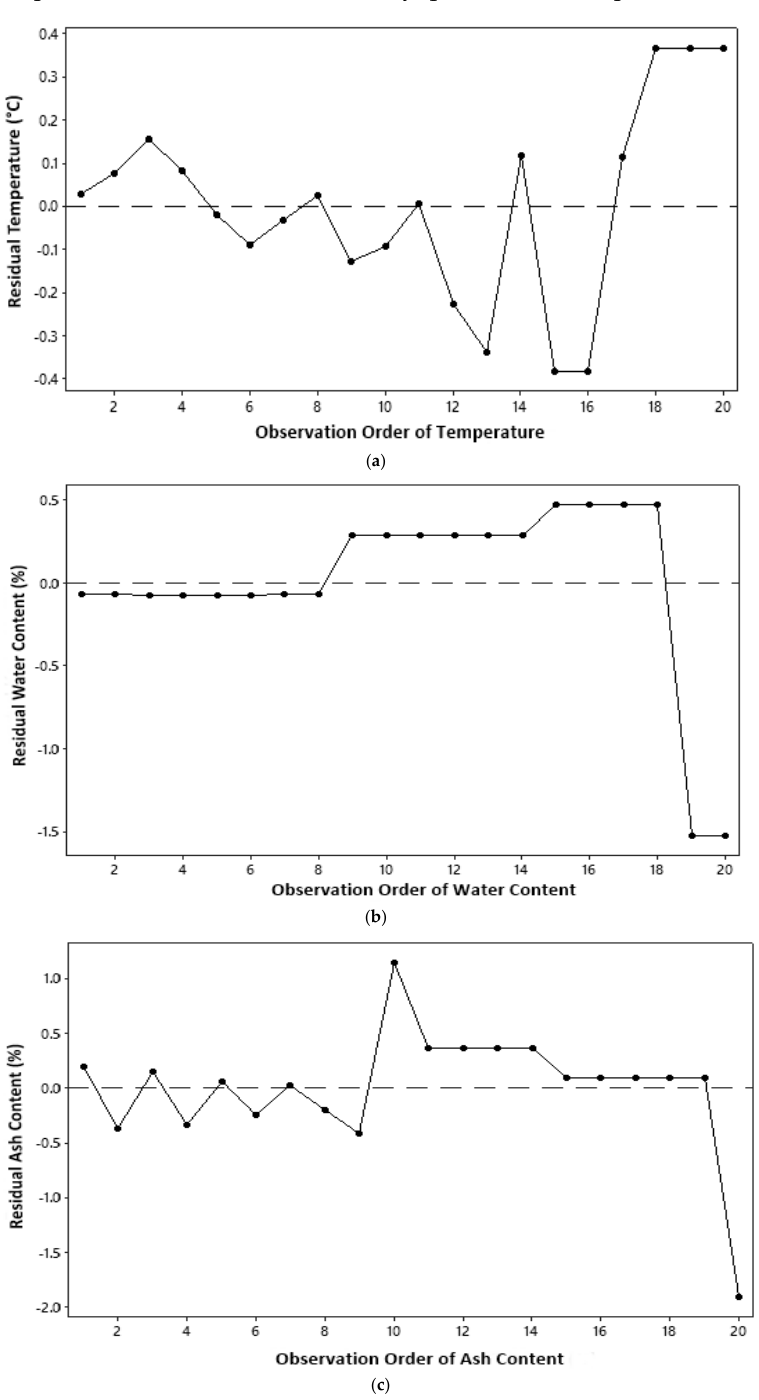
Figure 3. Independent assumption test: ( a ) temperature; ( b ) water content; ( c ) ash content.